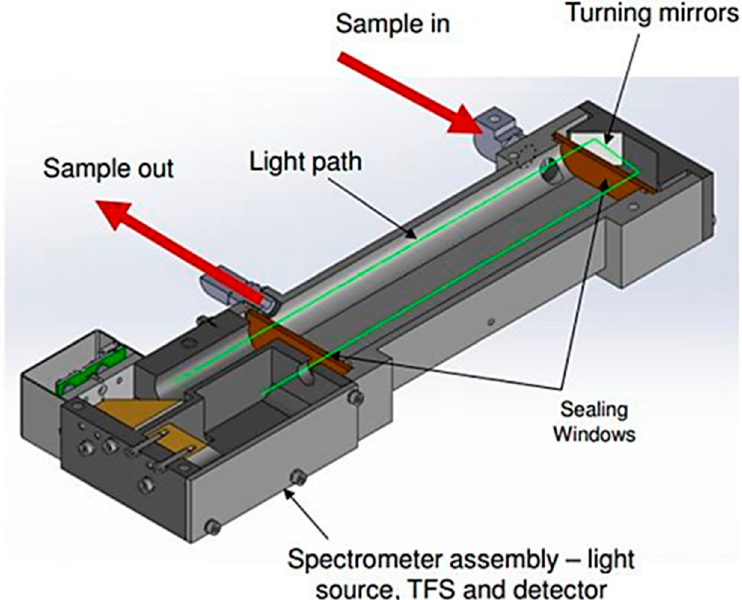
Figure 3. Schematic illustration of on-line syngas analyzer.